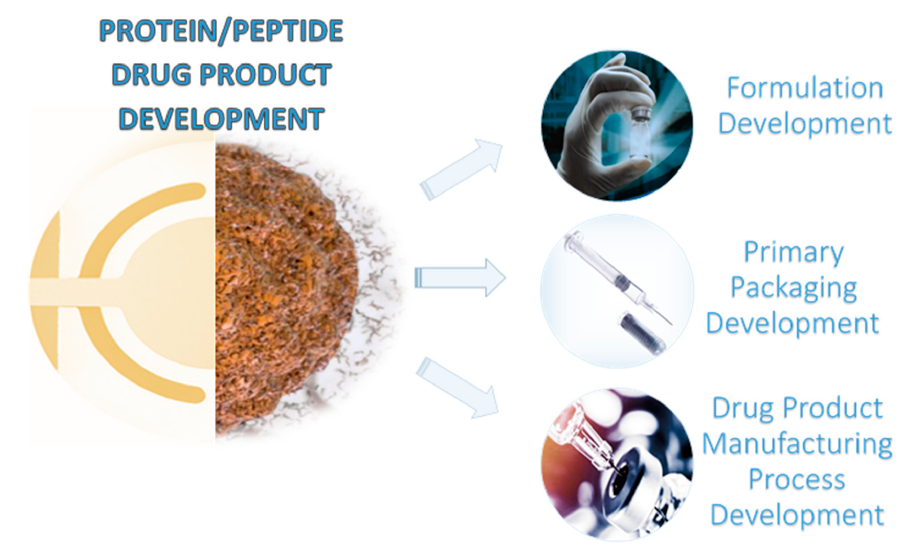
Figure 1. Key research findings of quartz crystal microbalance (QCM) applications in peptide- and protein-based drug product development. protein-based drug product